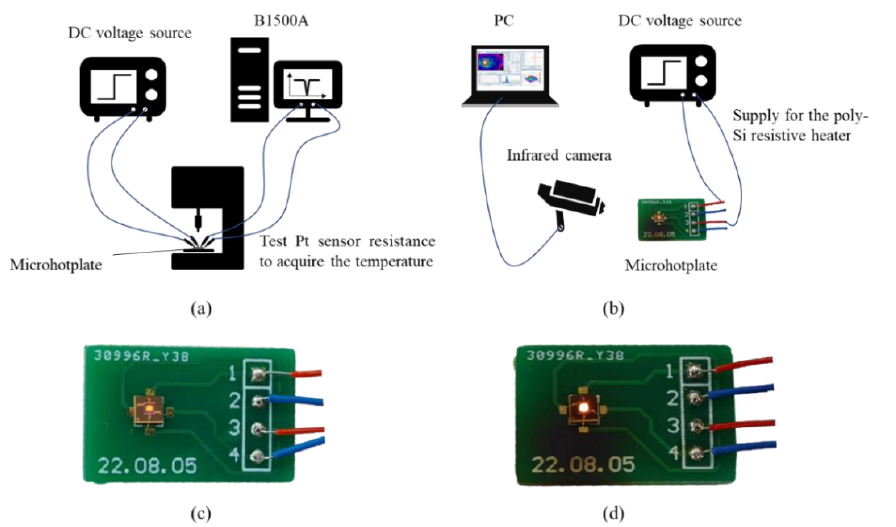
Figure 7. Test system connection: ( a ) electric performance; ( b ) thermal performance; ( c ) Sample − 1 and ( d ) Sample − 2 bonded with PCB.